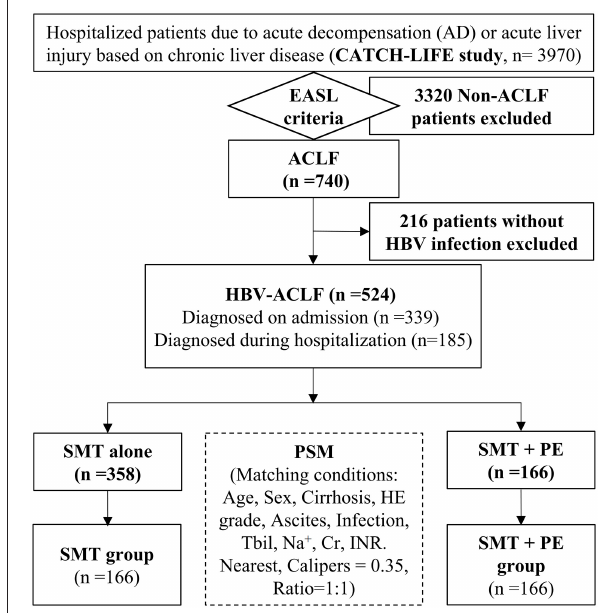
FIGURE 1 | Flow chart of the study. HBV, hepatitis B virus; ACLF, acute-on-chronic liver failure; SMT, standard medical therapy; PE, plasma exchange; PSM, propensity score match; HE, hepatic encephalopathy; Tbil, total bilirubin; Na + , serum sodium; Cr, serum creatinine; INR,